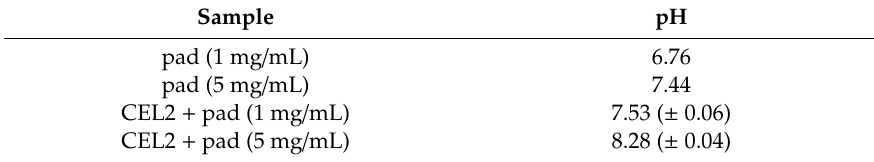
Table 1. Padina pavonica solutions pH evaluation before (pad) and after (CEL2 + pad)